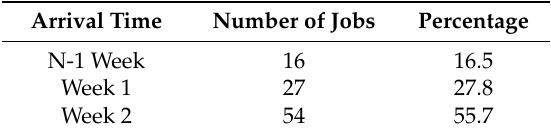
Table 2. The new parts’ arrival time (August 2015 to October 2015). Arrival Time